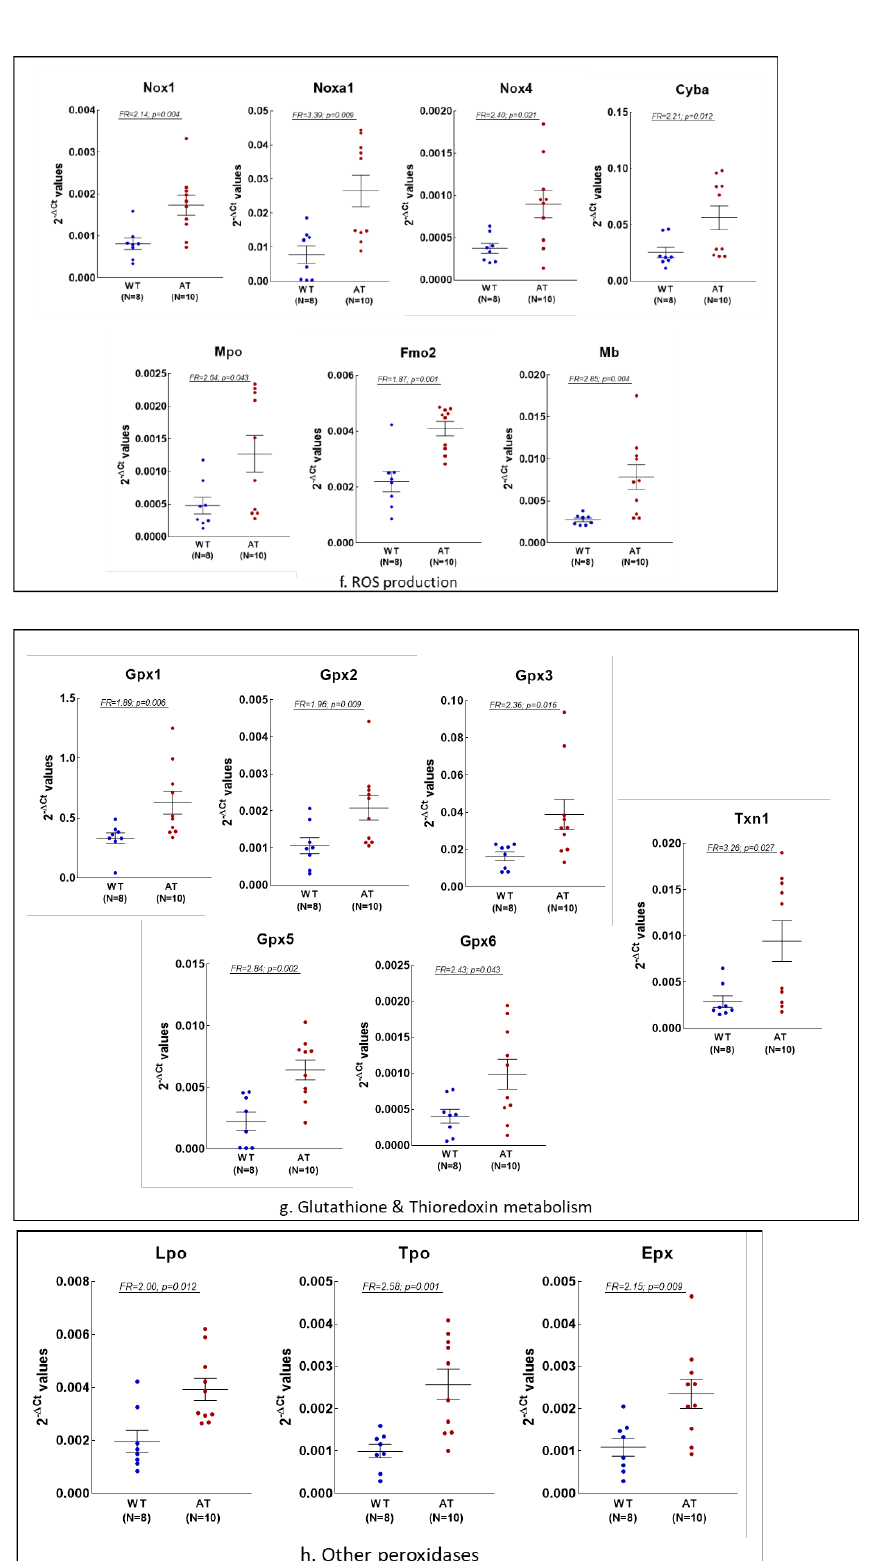
Figure 2. Inflammation and redox-related genes that are differentially expressed in the hippocampus of AT mice (N = 10) vs. WT mice (N = 8), exhibiting |FR| values > 1.8. Data are presented as 2 − ∆ CT values, and lines represent the expression average ± standard error of the mean (SEM). Comparisons between mice groups were made using the Mann–Whitney U-test, and differences were considered significant for p <